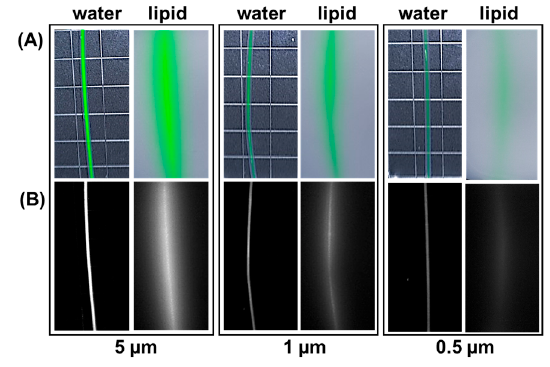
Figure 4. Representative example showing fluorophore 12 at differing concentrations in PTFE tubing of 2 mm external diameter imaged using the Quest spectrum instrument. Images taken with tubing submerged to a depth of 1 cm in water of 1% intralipid. ( A ) White light image with fluorescence superimposed in green colour. ( B ) Fluorescence image shown in black and white for